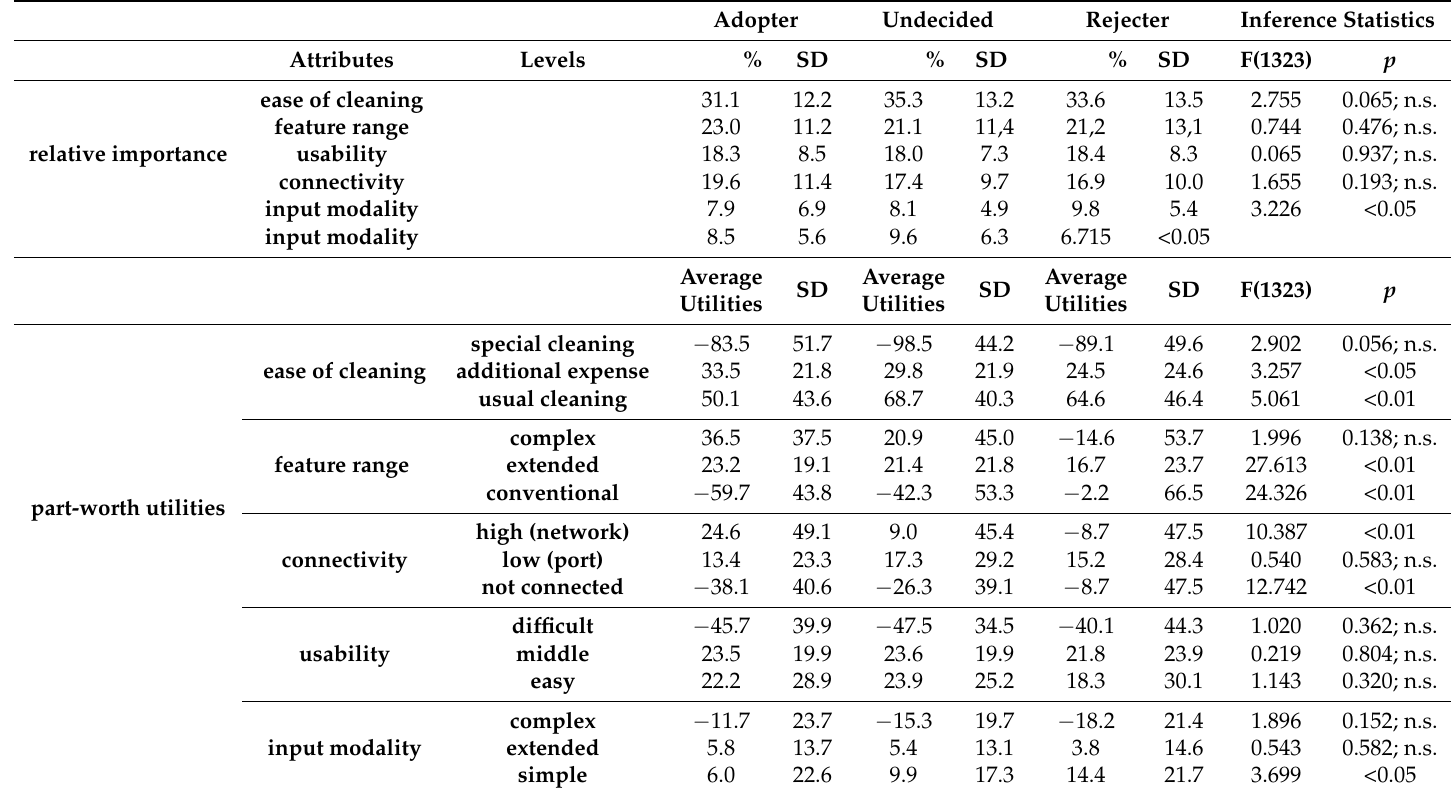
Table A4. Descriptive and inference statistics referring to the conjoint decisions referring to the smart jacket comparing three user